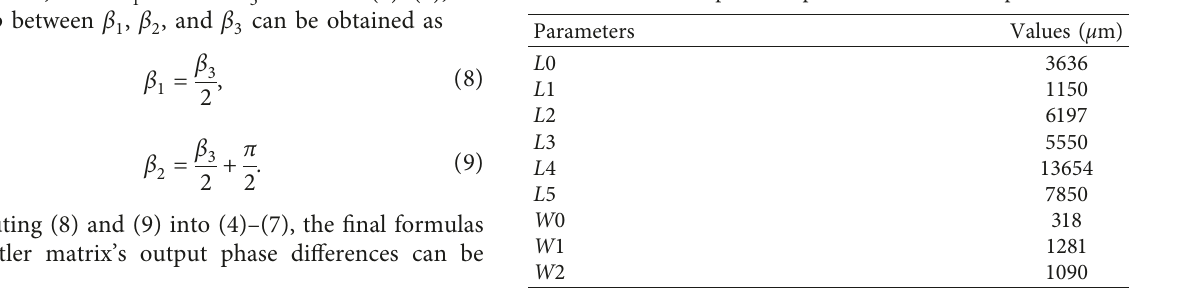
Figure 4: (a) Coupler model with 30 ° output phase difference. (b) Simulation of the coupler with 30 ° output phase difference. Table 3: Optimized parameters of the coupler.